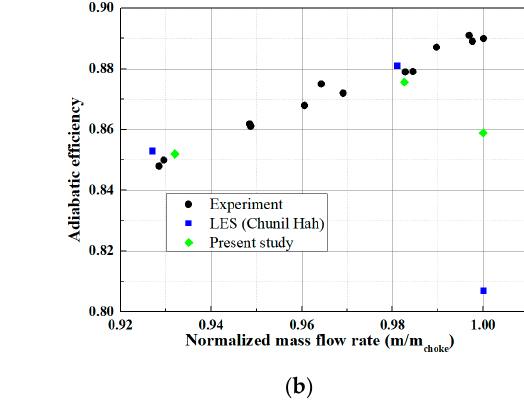
Figure 3. Comparison of the numerical and experimental data of the rotor performance. ( a ) Total pressure ratio. ( b ) Adiabatic efficiency.